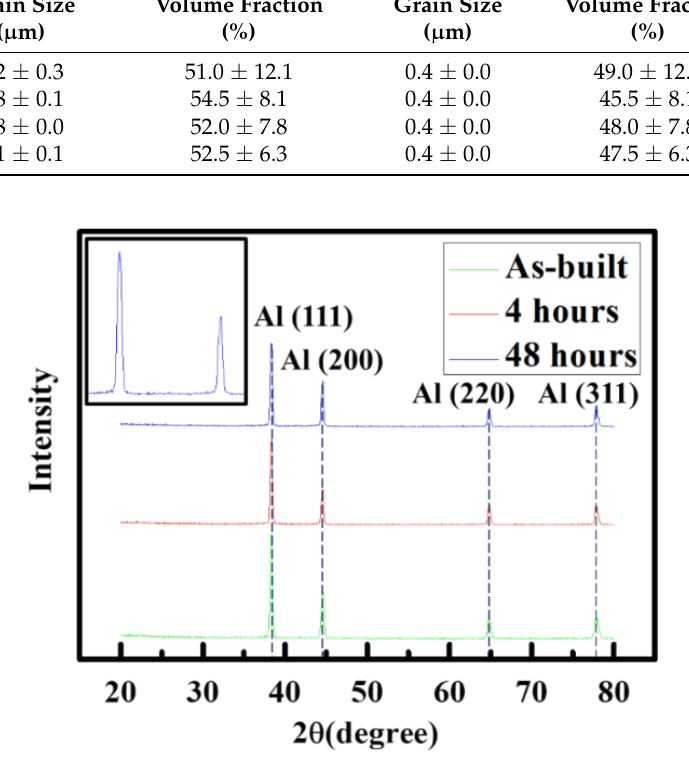
Figure 4. XRD results of the as-built and heat-treated samples.